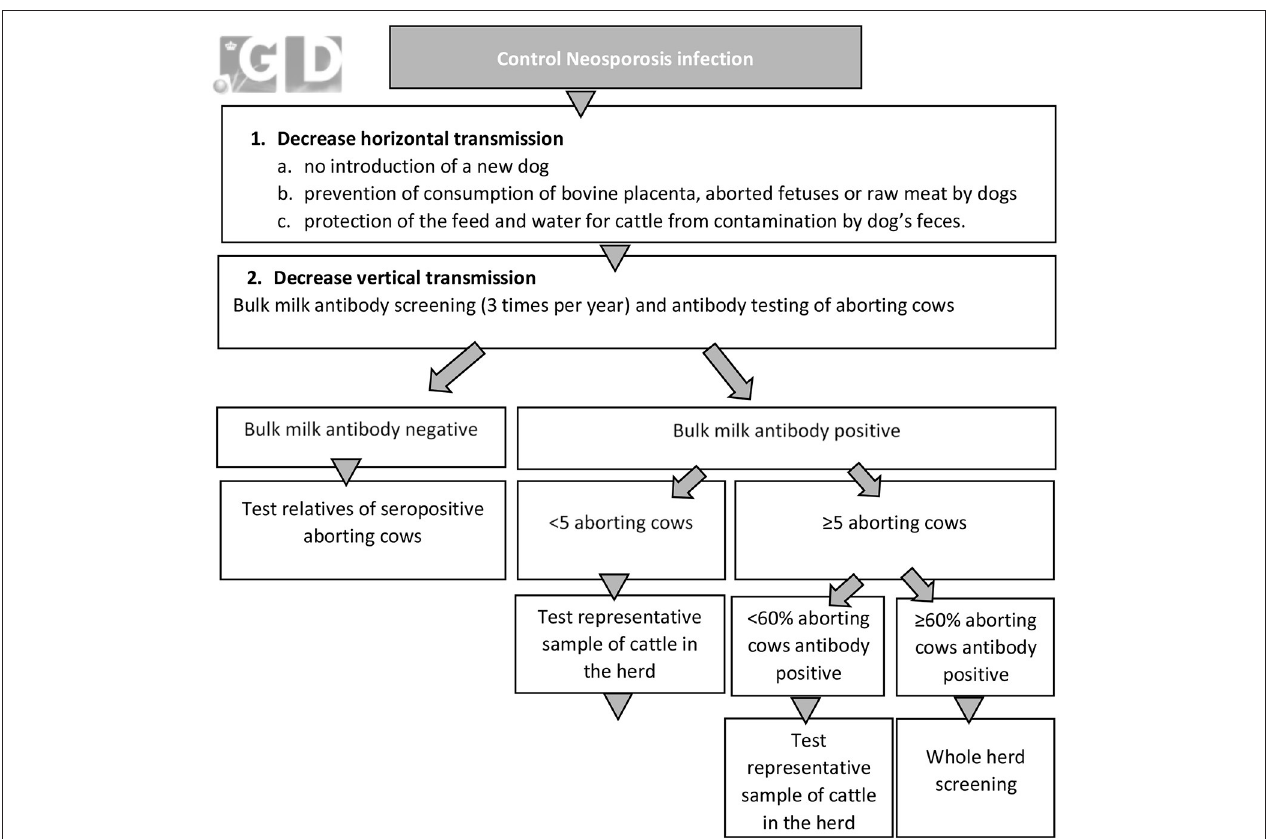
FIGURE 6 | Graphical overview of the voluntary neosporosis control program (Royal GD, Deventer, the Netherlands) in the Netherlands that was implemented in 2003.